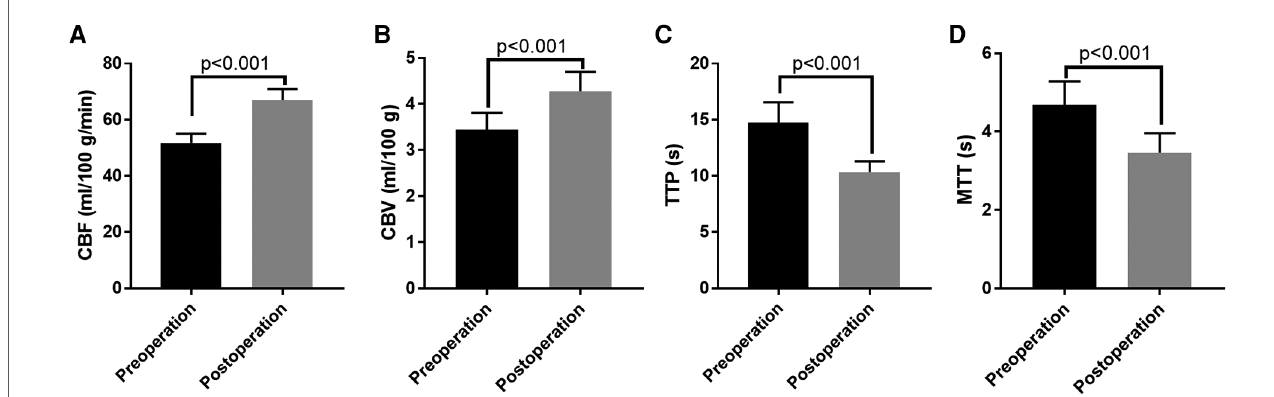
FIGURE 4 The comparisons of the perfusion parameters after CT perfusion imaging of patients before and after surgery. ( A ) The comparison of CBF; ( B ) The comparison of CBV; ( C ) The comparison of TTP; ( D ) The comparison of MTT. CBF, cerebral blood fl ow; CBV, cerebral blood volume; MTT, mean transit time; TTP, time to peak.